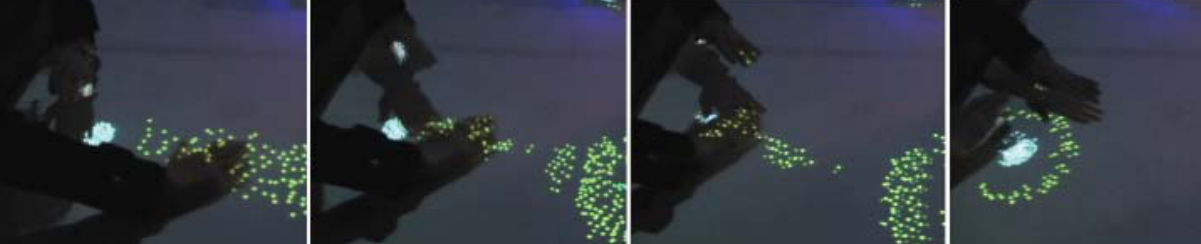
Figure 2: Agents projected onto a capacitive surface. A player leads some agents into a separate